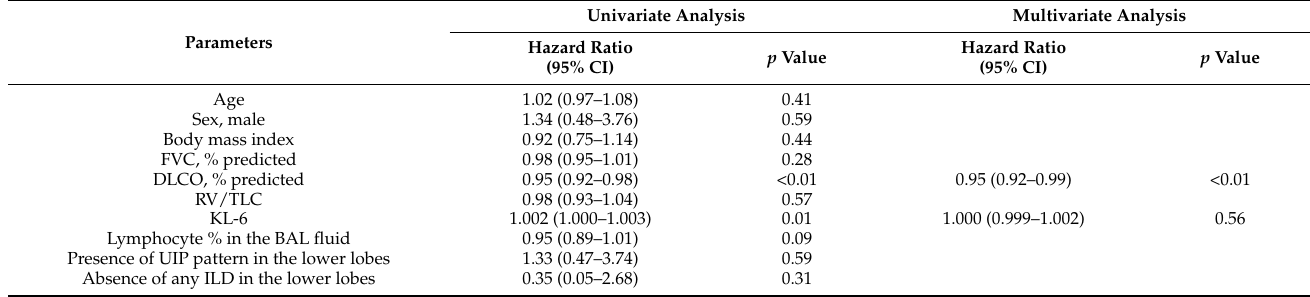
Table 4. Cox proportional hazards model assessment of potential predictors of mortality in patients with secondary PPFE.